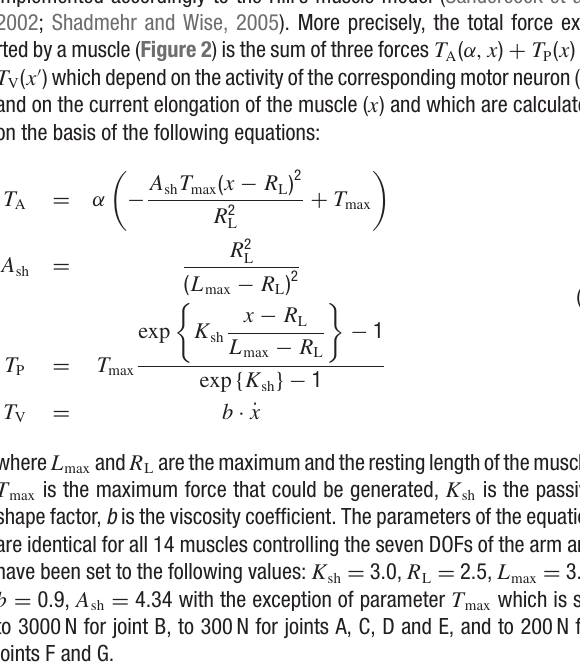
joints that extend/flex the first and second phalanx of thumb in the same range of PIP and DIP joints of the other four fingers: [ − 90 ◦ , + 0 ◦